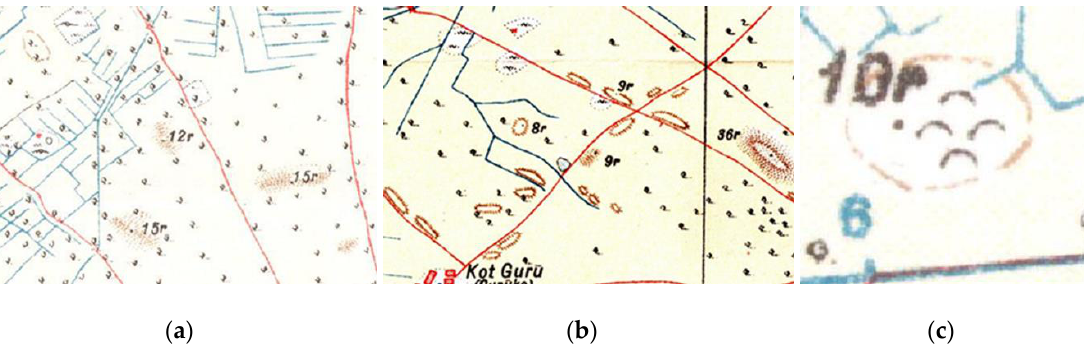
Figure 11. ( a ) Form-line and linear shaded mound features with spot heights on the same sheet; ( b ) Hachure and linear shaded mound features with spot heights and close to roads on the same sheet; ( c ) Combination of mound and graves (Images courtesy of Cambridge University Library).